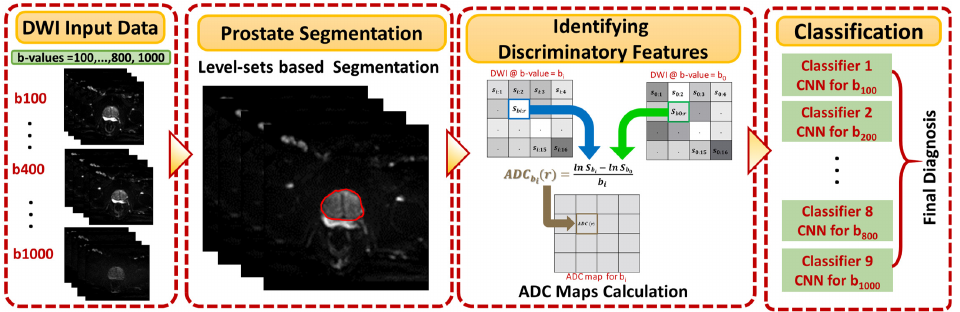
Figure 1. Overall workflow of the proposed model showing the DWI input data at nine b-values and its three basic steps, which are prostate segmentation, calculation of ADC maps as discriminating features, and the identification of slices with tumor using previously-trained CNN